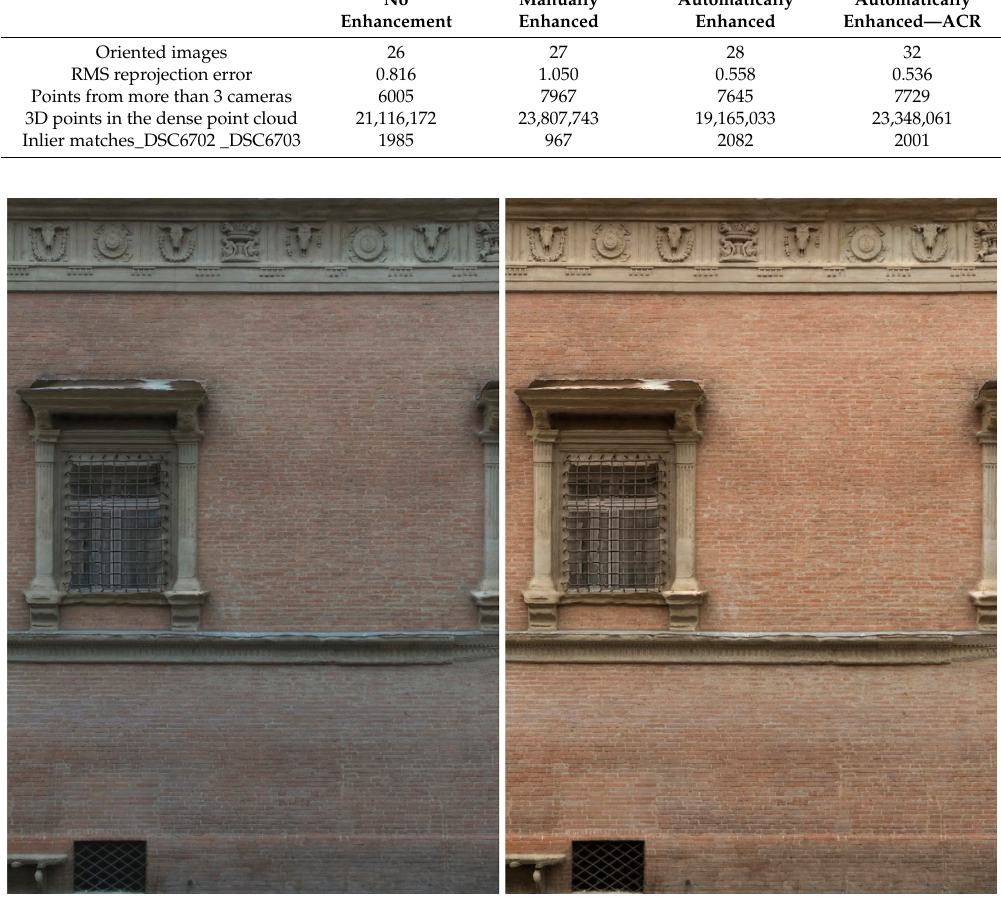
Figure 10. Bologna, Palazzo Albergati: comparison between the textured 3D model without ( left ) and with color correction ( right ).